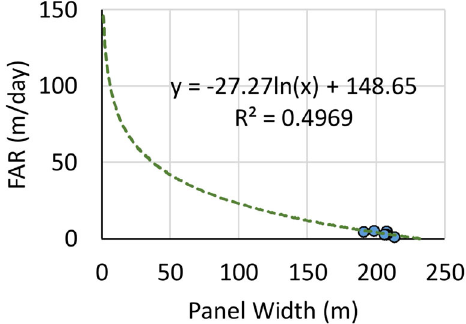
Fig. 13 Relationship between panel width and FAR, a power regression analysis